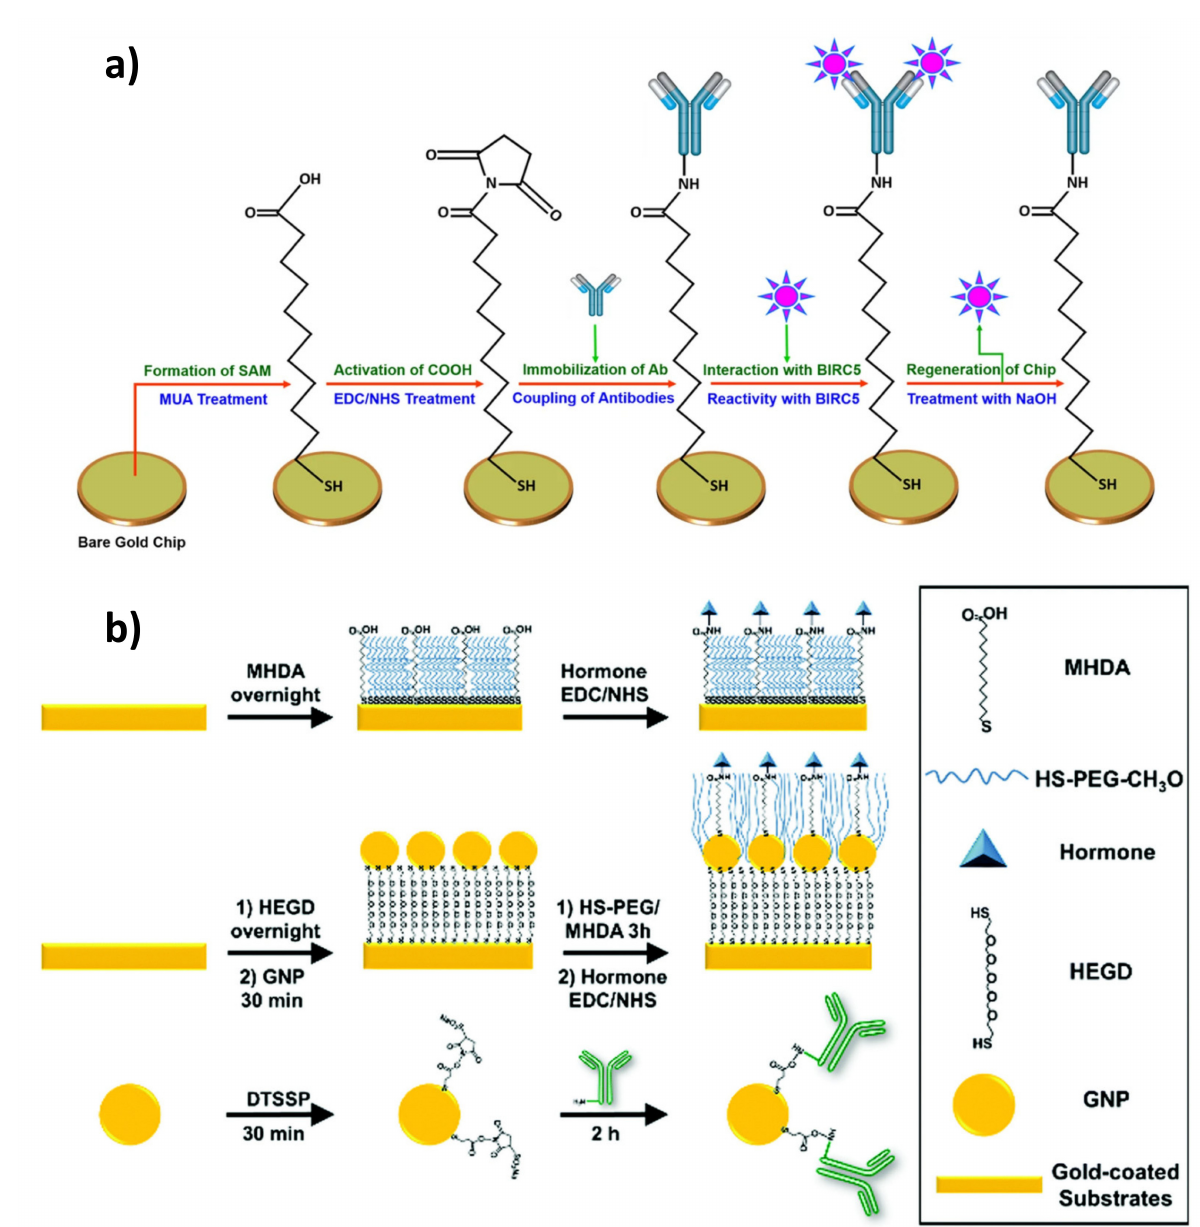
Figure 2. Examples of the utilization of various n -alkanethiolate and mixed SAMs in SPR immunosensing. ( a ) Schematic representation of ω -carboxylic acid-based SPR immunosensor fabrication with the use of EDC/NHS coupling, ( b ) various bifunctional linkers used for gold surface functionalization: MHDA/mercaptoundecanol mixed SAM (top), HEGD SAM for AuNPs self-assembly (middle), and DTSSP linker-mediated conjugation to AuNPs. Adapted with permission from Jena et al. [49] (under the terms and conditions of the Creative Commons CC BY License) and Castiello et al. [53] (Copyright © (2019) Royal Society of